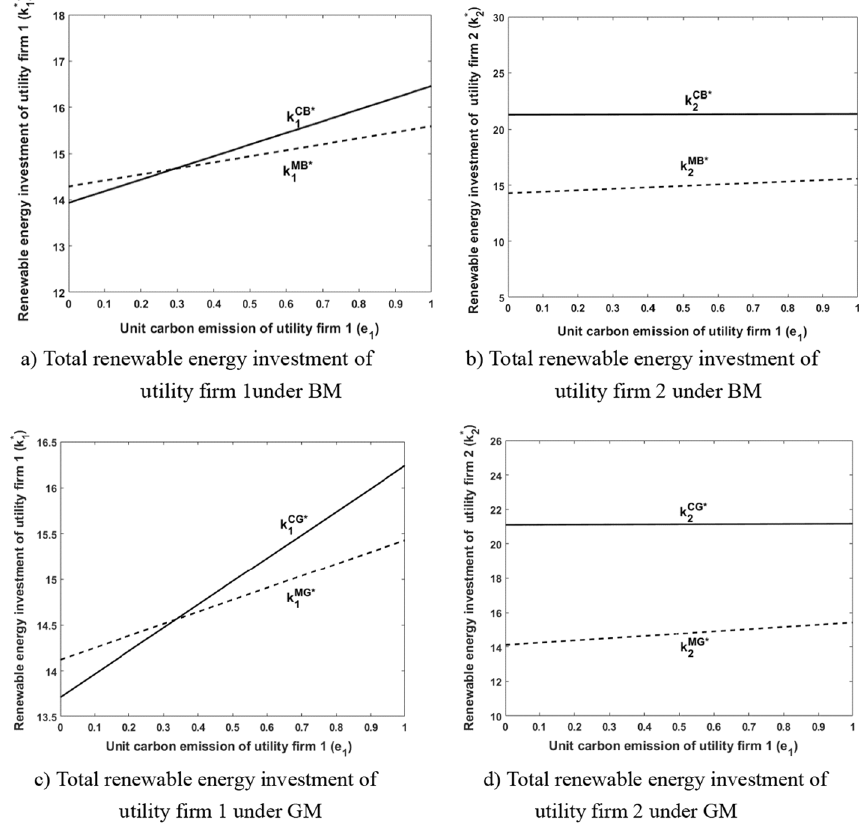
Fig. 3 Impacts of unit carbon emission on renewable energy